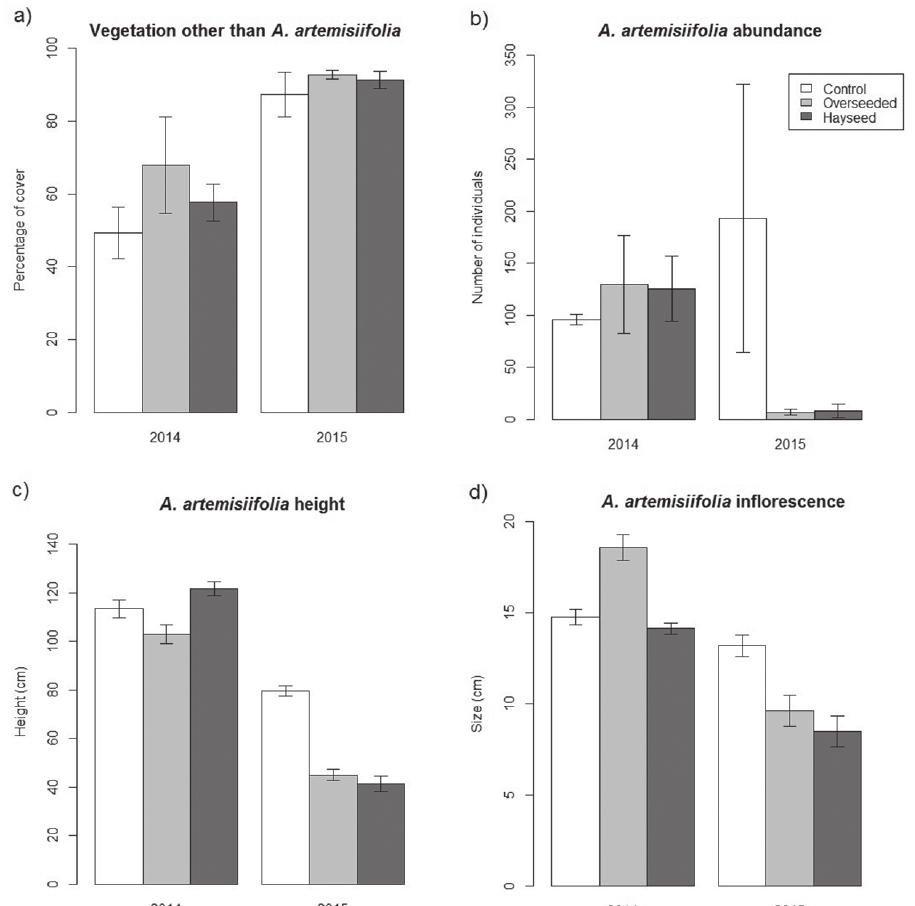
Figure 1. A. artemisiifolia abundance and traits in experimental plots. Mean values (± SE) for a percent- age cover of vegetation other than A. artemisiifolia b number of individuals c plant height and d inflo- rescence size of A. artemisiifolia in the three treatments (control, over-seeded and hayseed) in September 2014 and